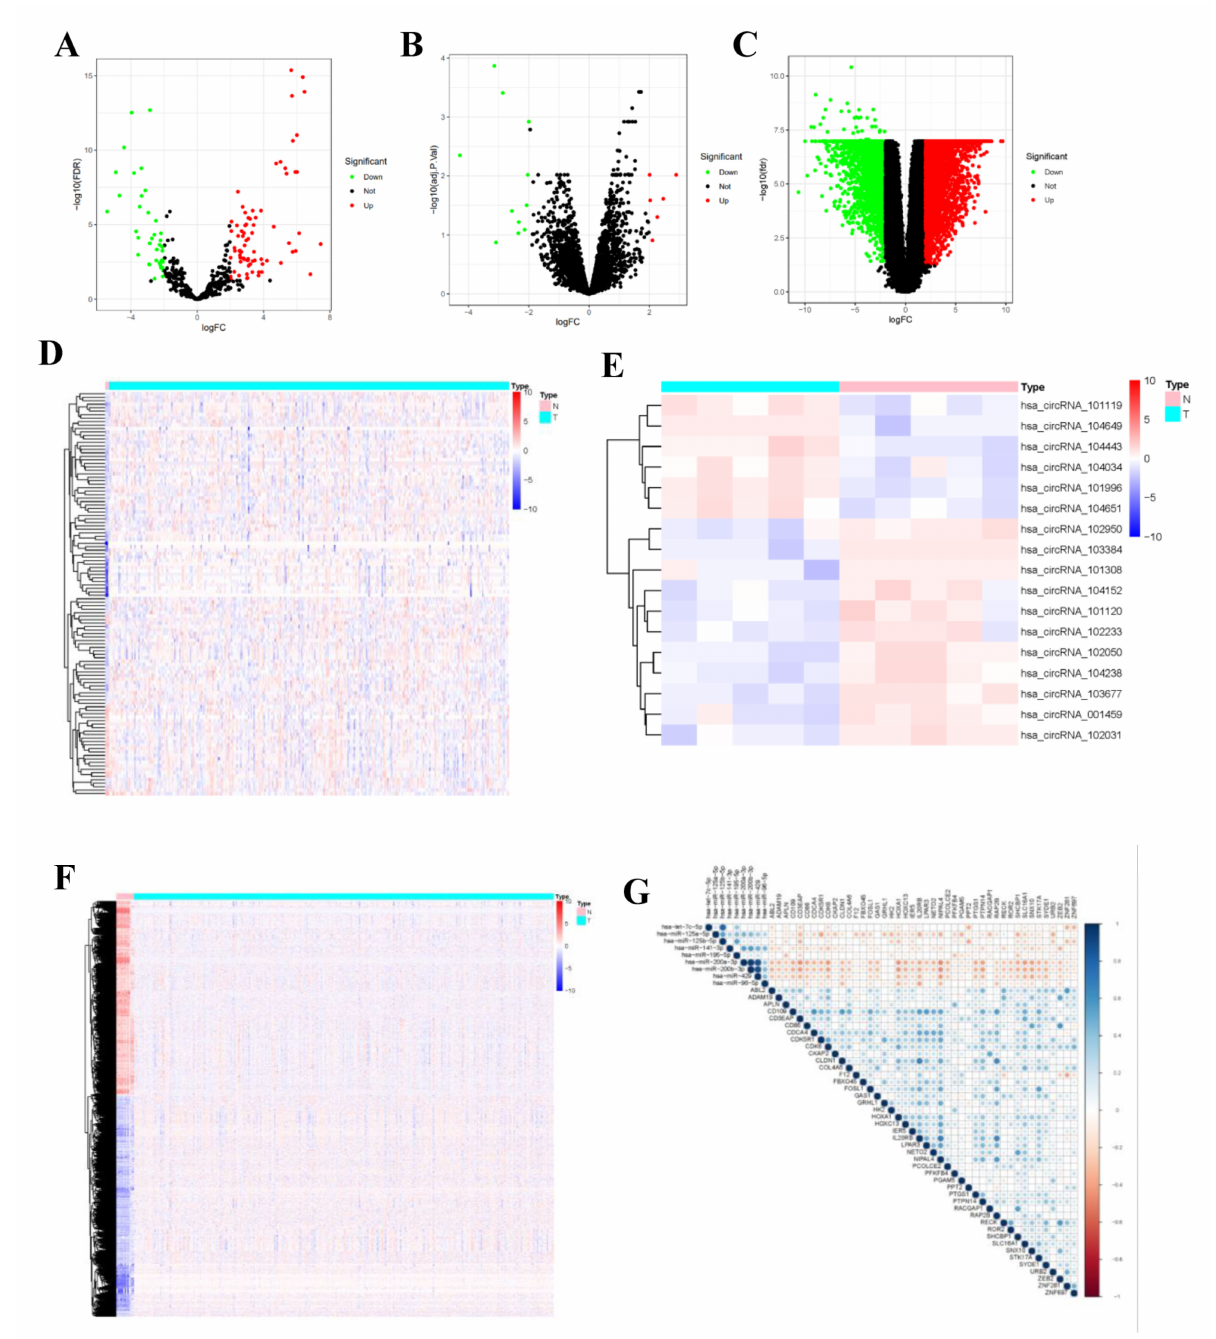
Figure 2. Identified DEcircRNAs, DEmiRNAs, and DEmRNAs. Provided are the volcano plot ( A ) and the heatmap ( B ) of 118 differentially expressed miRNAs between the two groups; the volcano plot ( C ) and the heatmap ( D ) of 7 differentially expressed cirRNAs between the two groups; and the volcano plot ( E ) and the heatmap ( F ) of 6136 differentially expressed protein-coding genes between the two groups; All differentially expressed genes had a log (fold-change) > 2.0 or < − 2.0 and the overall of FDR < 0.05. Red represents upregulate and green represent downregulate. The change in color represents the difference in expression. DE, differentially expressed. The heat map showing the correlations of the circRNA-miRNA ( G ), with blue representing positive correlations, red representing negative